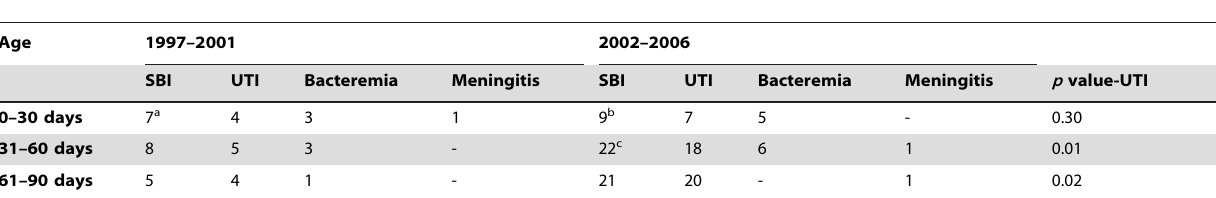
Table 4. SBIs by Age